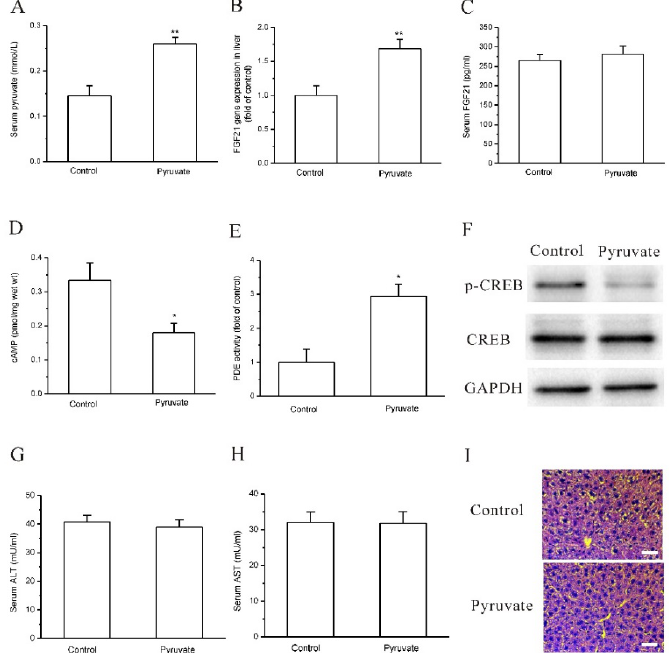
Figure 6. Pyruvate upregulated FGF21 expression in mice in vivo. ( A ): Intraperitoneal injection of pyruvate significantly increased serum pyruvate levels in C57BL/6J mice compared with the control (** p < 0.01, n = 10). ( B ): The pyruvate-treated mice had significantly higher FGF21 gene expression in liver than the control (** p < 0.01, n = 10). ( C ): Serum FGF21 levels were not changed by pyruvate treatment in mice compared with the control ( n = 10). ( D ): cAMP levels in mouse liver were significantly decreased by pyruvate treatment in mice (* p < 0.05, n = 10). ( E ): PDE activity in mouse liver was significantly activated by pyruvate injection in mice (* p < 0.05, n = 10). ( F ): CREB phosphorylation was inhibited in liver after pyruvate injection compared with the control. ( G , H ): ALT and AST activities in mouse serum were not significantly different between pyruvate-treated group and the control group. ( I ): H&E staining showed that the liver tissues had normal morphology in mice of pyruvate-treated group without obvious difference to the control (bar is 20 µ